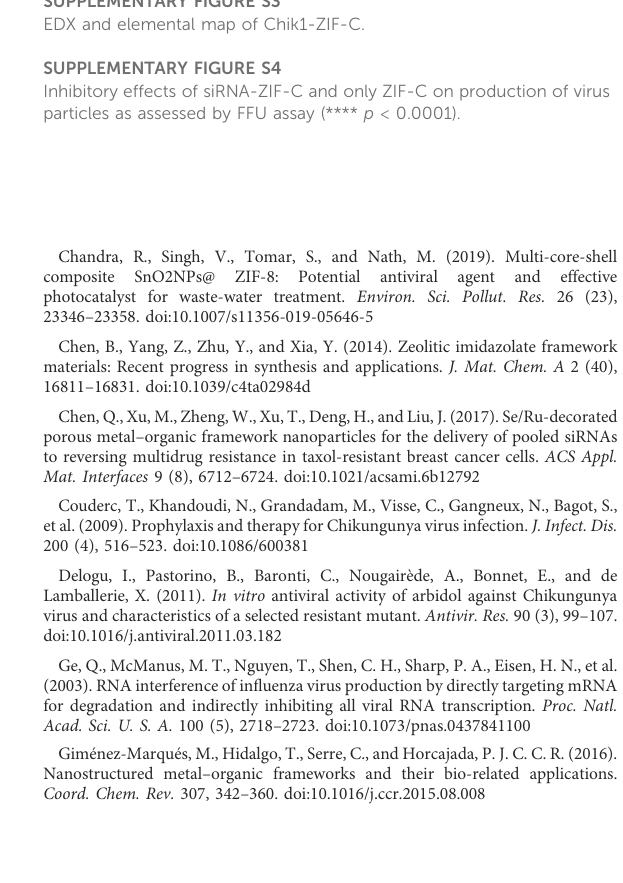
SUPPLEMENTARY FIGURE S1 TEM image of Chik1-ZIF-C. SUPPLEMENTARY FIGURE S2 Zn standard curve (ppm vs intensity) to determine concentration of Zn in the prepared Chik-ZIF-C. SUPPLEMENTARY FIGURE S3 EDX and elemental map of Chik1-ZIF-C. SUPPLEMENTARY FIGURE S4 Inhibitory effects of siRNA-ZIF-C and only ZIF-C on production of virus particles as assessed by FFU assay (**** p <